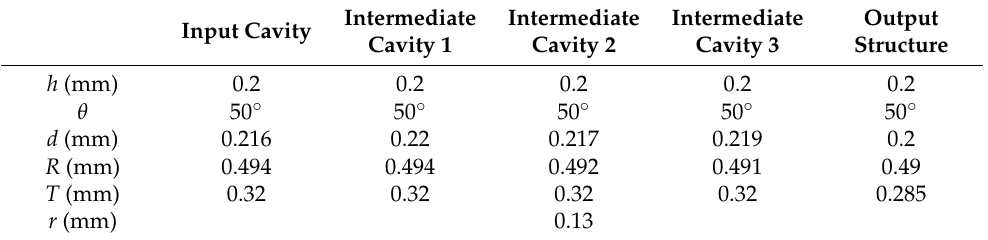
Table 1. Geometric parameters of each cavity.